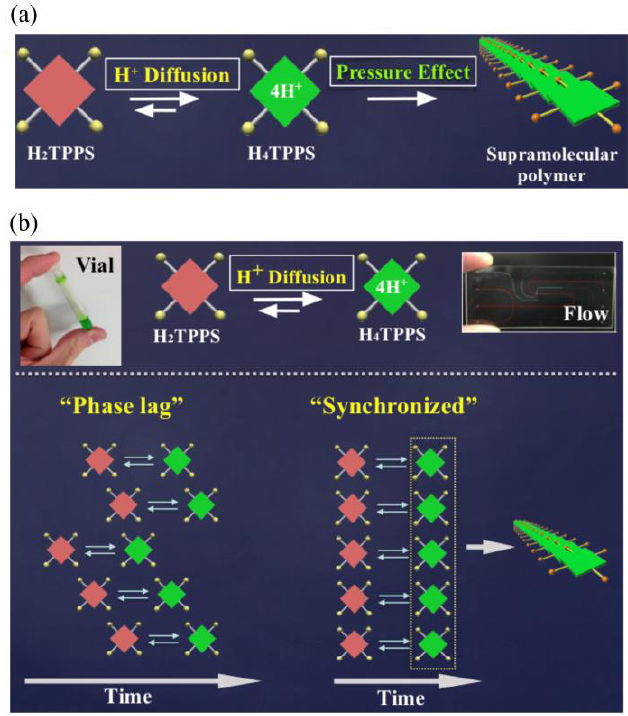
Figure 7. ( a ) Cartoon representation of the organized effects of proton diffusion and pressure on self-assembly. ( b ) Schematic representation of the synchronous behavior; cluster model of protonation/deprotonation equilibria along a time axis. Spontaneous protonation of H 2 TPPS would lead to adjusting time phases of protonation/deprotonation reaction over the molecular scale (i.e., synchronizing toward self-assembly). This phenomenon would also induce long-range intermolecular interactions.